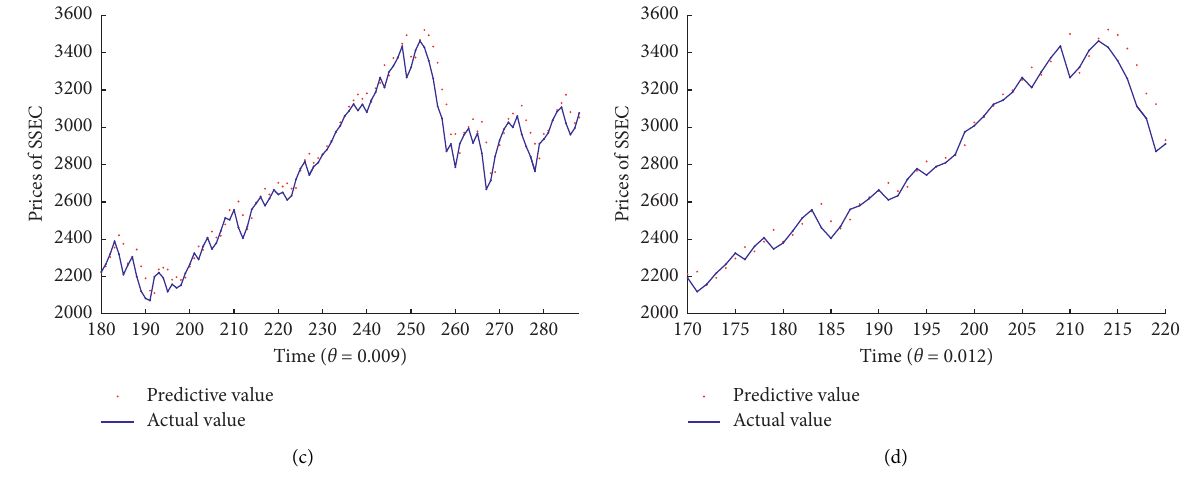
Figure 7: Volatility degree prediction of SSEC with different thresholds θ .